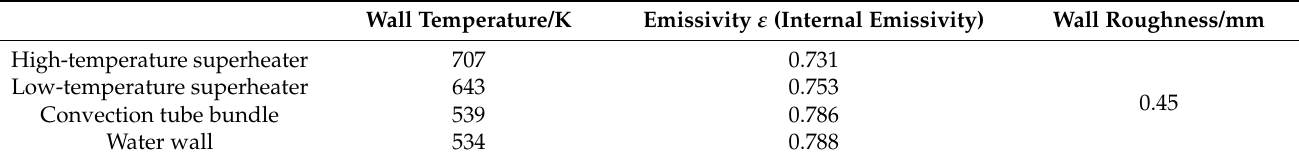
Table 3. Setting of the boundary conditions.